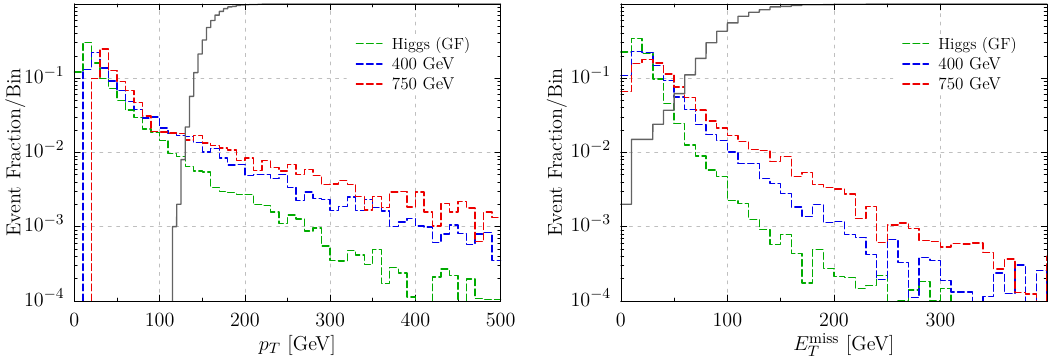
Figure 9. Distributions for the reconstructed p T of hardest jet (left) and E miss soft bomb GF benchmarks. Also shown are applicable turn-on e(cid:14)ciency curves (gray) [85], with the same vertical scale as the corresponding distributions. These turn on curves are applied over the full j (cid:17) j < 4 : 9